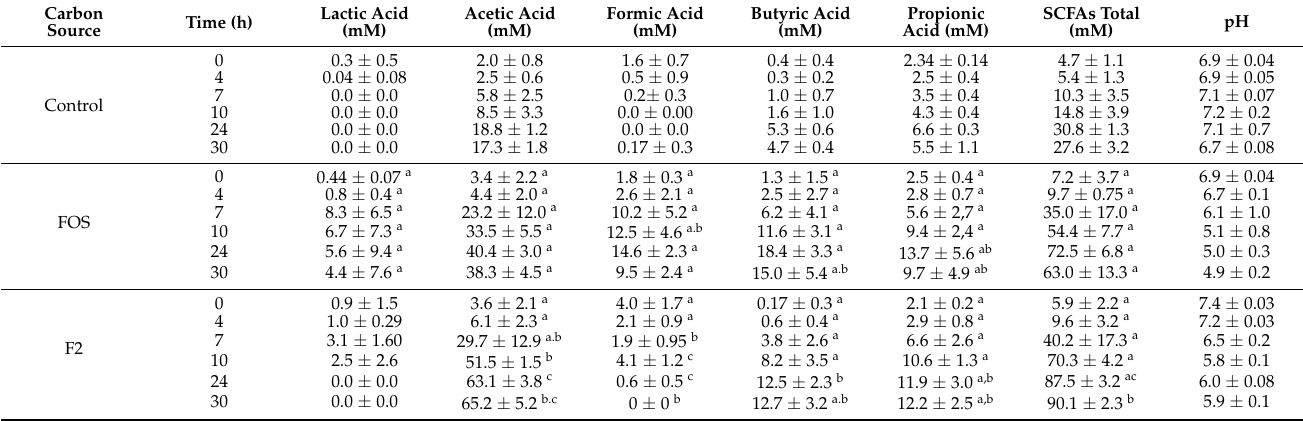
Table 3. Mean values of lactic acid, SCFA concentrations (mM) and pH during fermentation